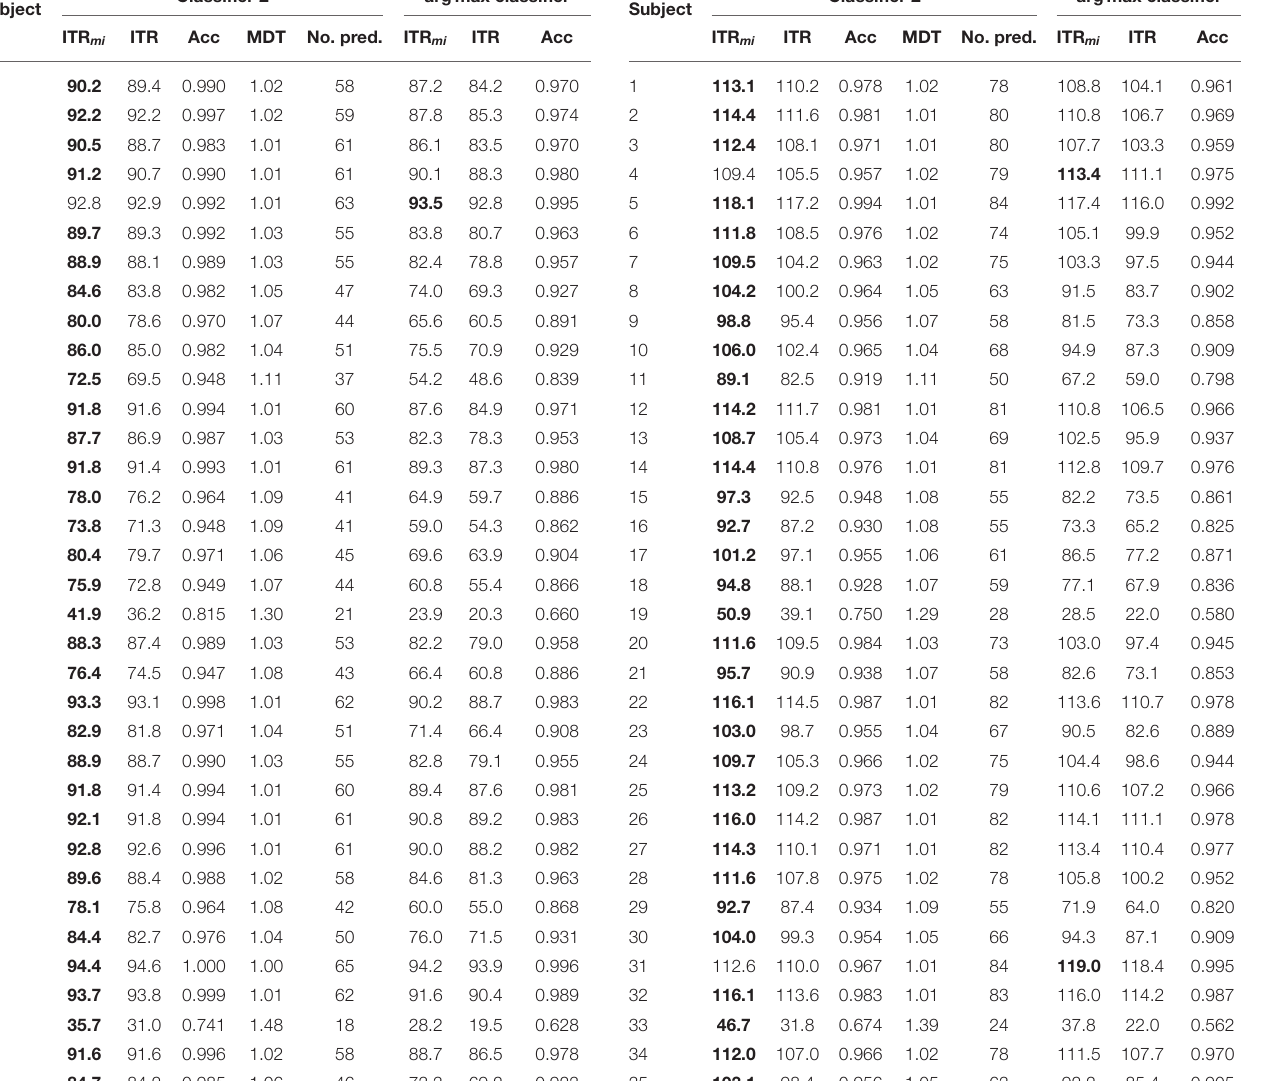
TABLE 6 | Classifier 2 compared with the arg max classifier using four